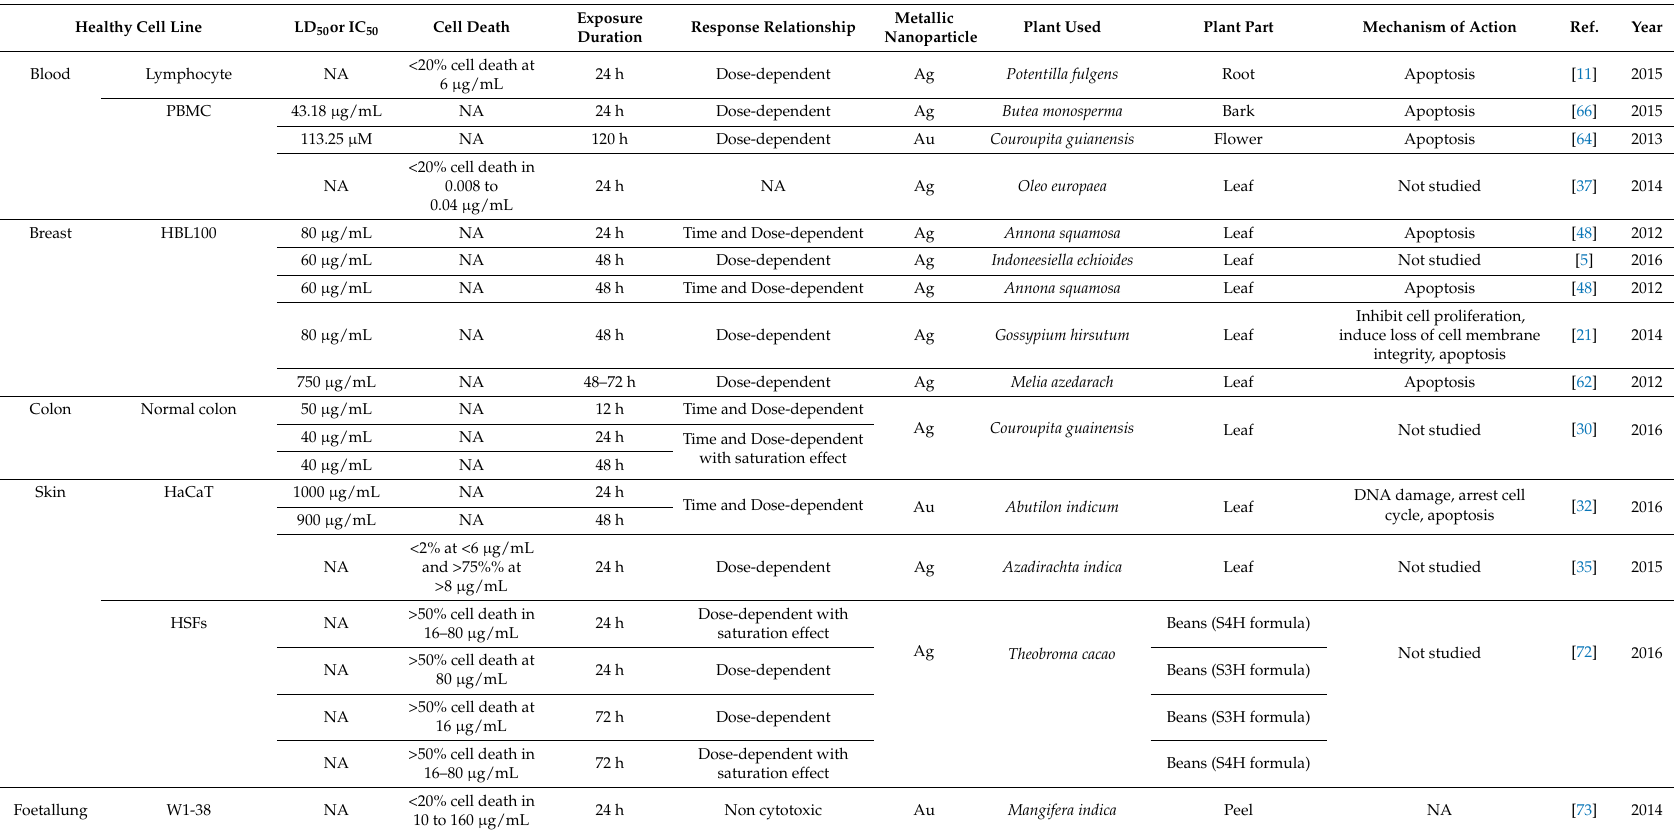
Table 2. The cytotoxicity of plant-mediated syntheses of metallic nanoparticle on normal cells (in